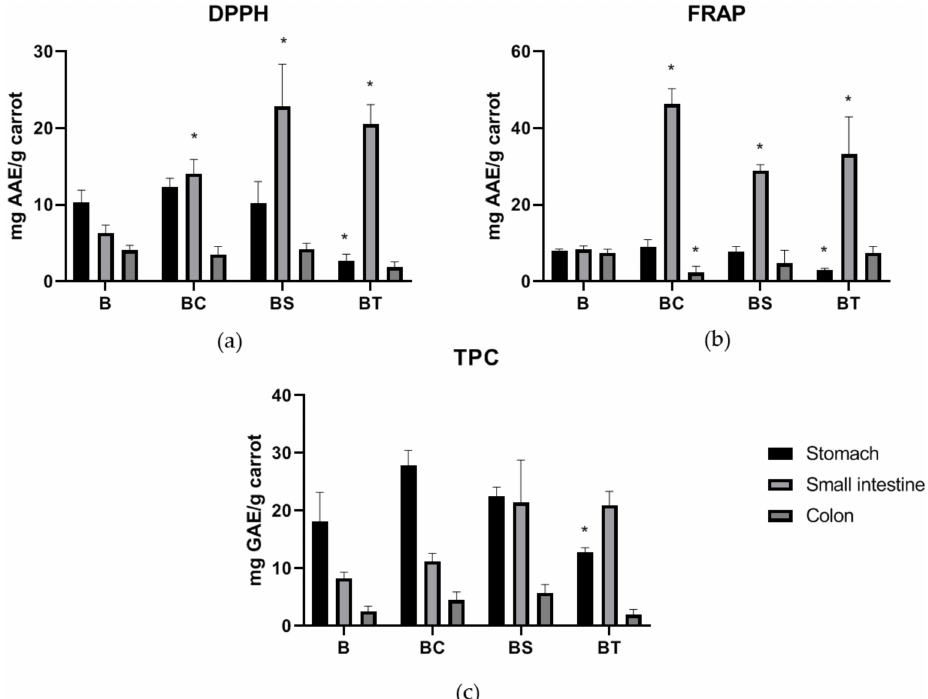
Figure 1. Bioaccessible phytochemicals were increased when associated with lipids. DPPH ( a ), FRAP ( b ), and total phenolic content ( c ) of carrot control and di ff erent carrot-oil mixtures from gastric, small intestinal and colonic fractions. Abbreviations: B (black carrot only), BS (black carrot and sunflower oil mixture), BT (black carrot and tallow mixture), and BC (black carrot and coconut oil mixture). * Significant di ff erences at p < 0.05 compared to control (B) were highlighted. No significant di ff erences were shown among di ff erent types of oil treatments. Results of DPPH and FRAP were expressed as mg ascorbic acid equivalent (AAE) per g of carrot on dry weight basis, and results of TPC were expressed as mg gallic acid equivalent (GAE) per g of carrot on dry weight